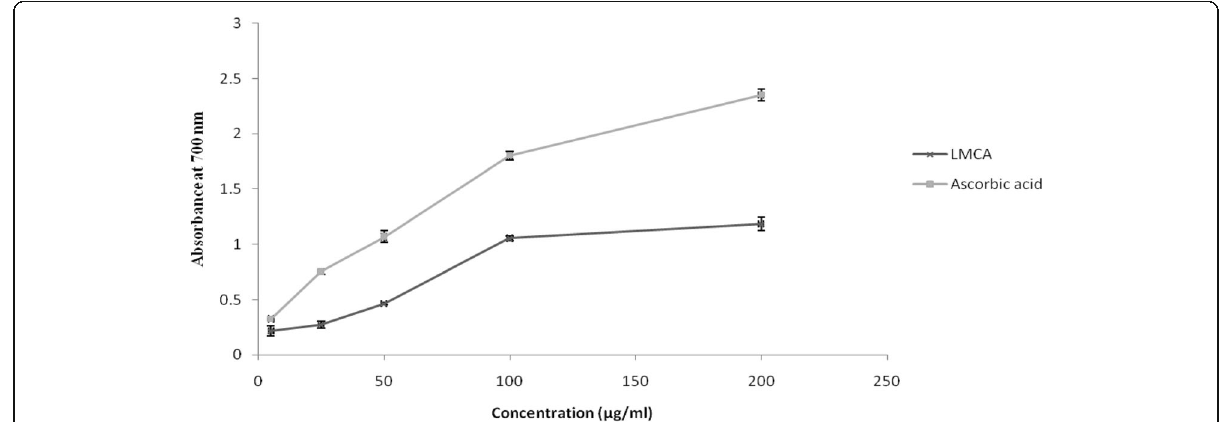
Fig. 2 Ferric reducing antioxidant activity (FRAP) of leaf methanolic extract of Colocasia affinis Schott along with the standard Ascorbic acid. (Mean ± SD, n =